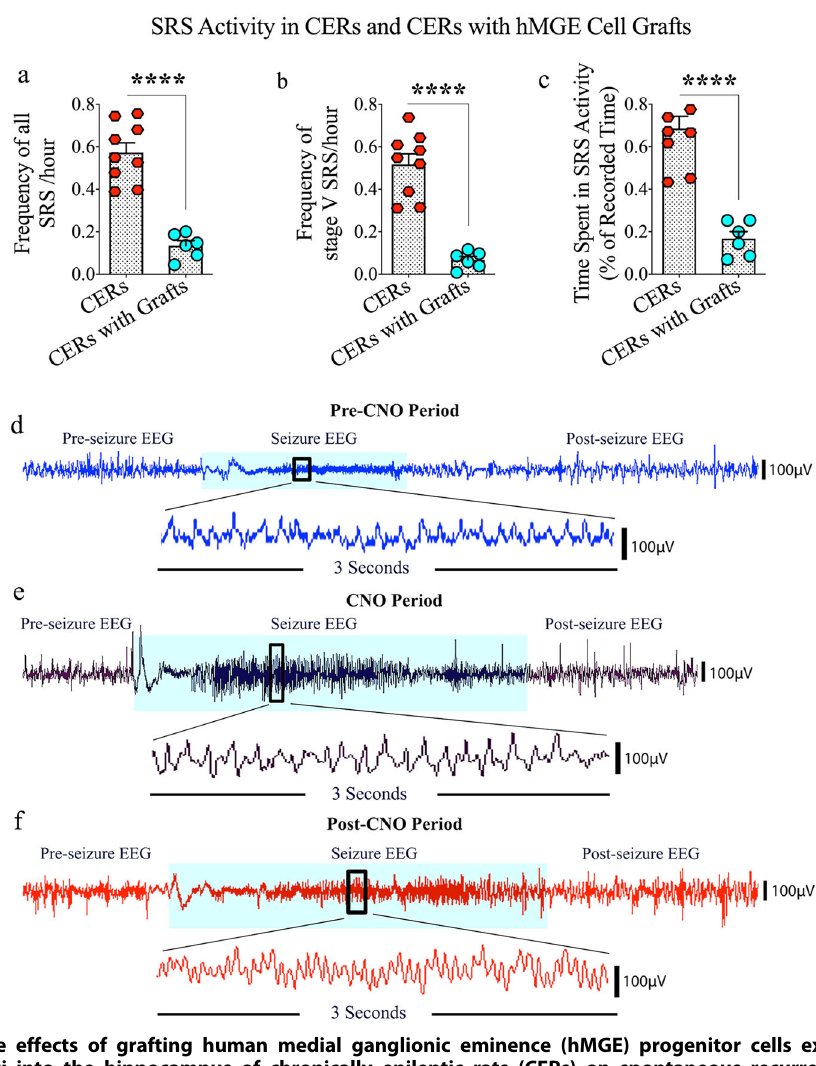
Fig. 2 Evaluation of the effects of grafting human medial ganglionic eminence (hMGE) progenitor cells expressing the Gi-protein- coupled receptor hM4Di into the hippocampus of chronically epileptic rats (CERs) on spontaneous recurrent seizure (SRS) activity. Quanti fi cation in the 4th month after grafting via continuous video-EEG recordings revealed that compared to the group of CERs receiving no grafts, the group of CERs receiving hMGE cell grafts displayed greatly decreased frequencies of all SRS ( a ) and stage V SRS ( b ). The grafted animals also spent much less time in seizure activity ( c ). d – f illustrate electroencephalographic (EEG) traces during the pre-clozapine-N-oxide (CNO), CNO, and post-CNO periods. Values in bar charts are presented as mean ± S.E.M. **** p < 0.0001 (unpaired, two-tailed Student ’ s t